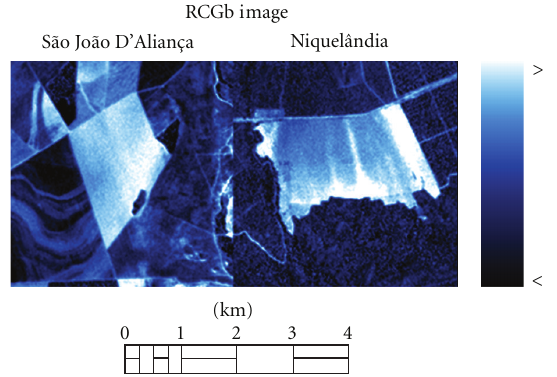
Figure 3: Spatial distribution of RCGb values in SJA and NIQ.